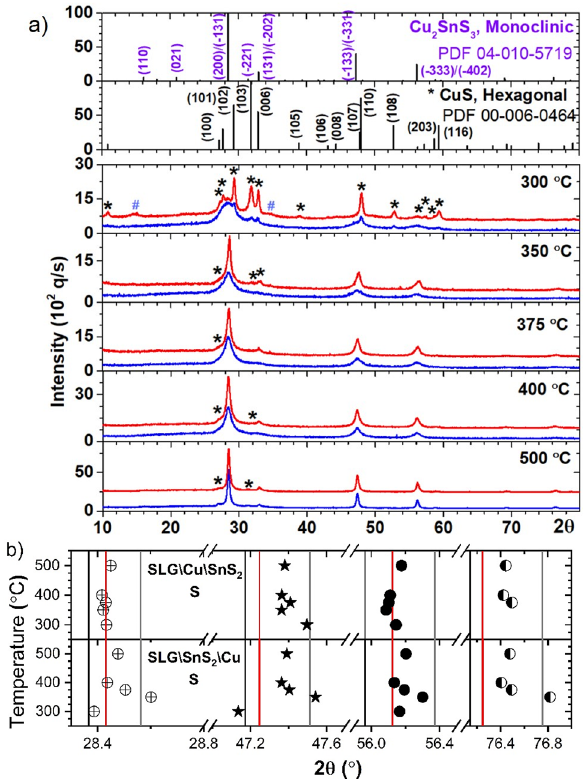
Figure 1. GIXRD analysis of the stacks annealed in sulfur atmosphere at 300, 350, 375, 400 and 500 °C. ( a ) GIXRD patterns of the SLG\Cu\SnS 2 stack (blue) and the SLG\SnS 2 \Cu stack (red, shifted vertically for a better representation). The ICDD patterns of monoclinic CTS (04-010-5719) and hexagonal CuS (00-006-0464) are also shown. There are some traces of crystalline CuSn 3.75 S 8 PDF 04-008-7270 (~ 3%) marked as “#” in the SLG\ SnS 2 \Cu stack annealed in sulfur atmosphere at 300 °C. ( b ) The angular positions of the most intense CTS peaks in relation to the ICDD cards of tetragonal (04-009-7947) (gray: (112), (204)/(220), (116)/(312), (316)/ (332)), cubic (04-002-6009) (black: (111), (220), (311), (331)) and monoclinic (04-010-5719) (red: (200)/(−131), (−133)/(−331), (−333)/(−402), (−135)/(−531))